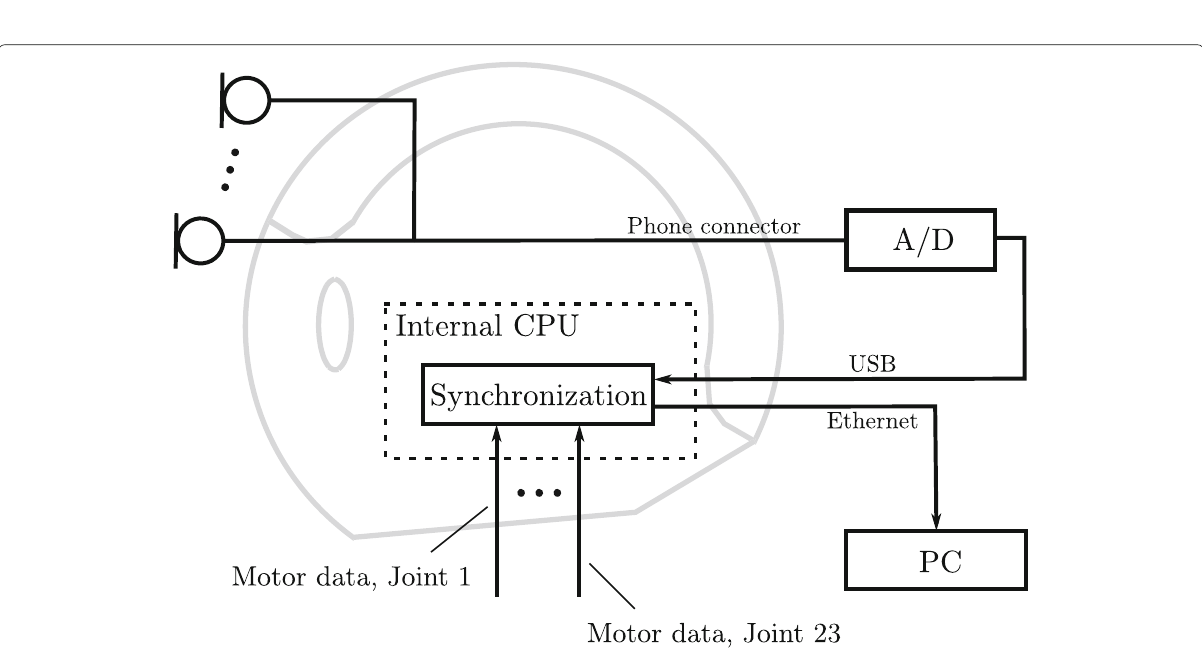
Fig. 5 Overview of recording setup. A detailed explanation is given in Section